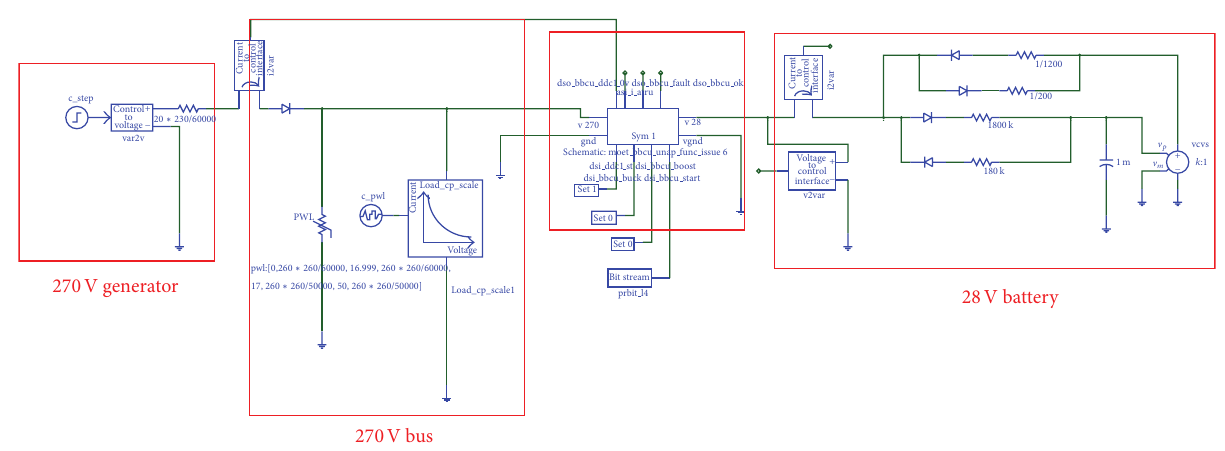
Figure 20: Test bench used for buffer mode.